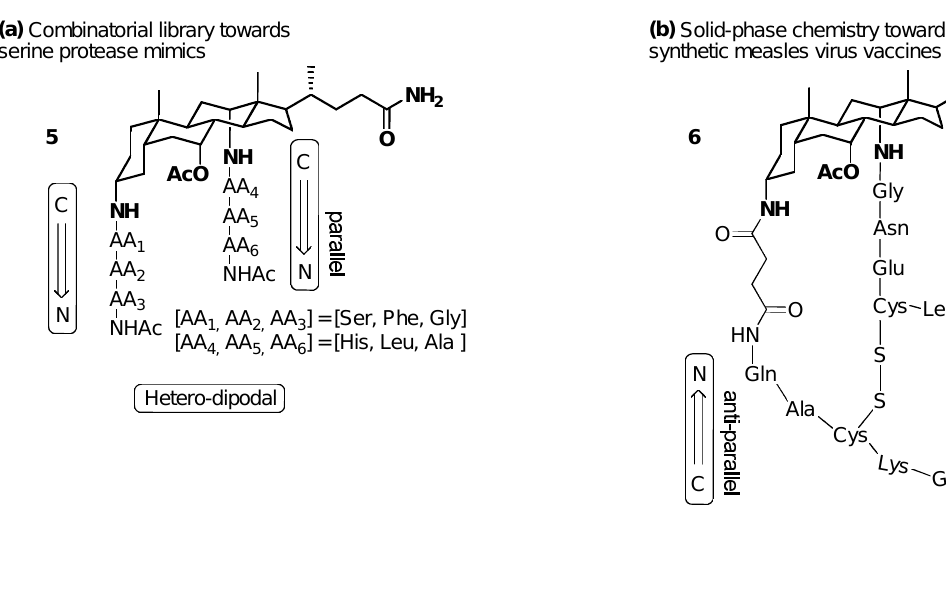
Figure 2. Bile acid-peptide conjugates contributed by our